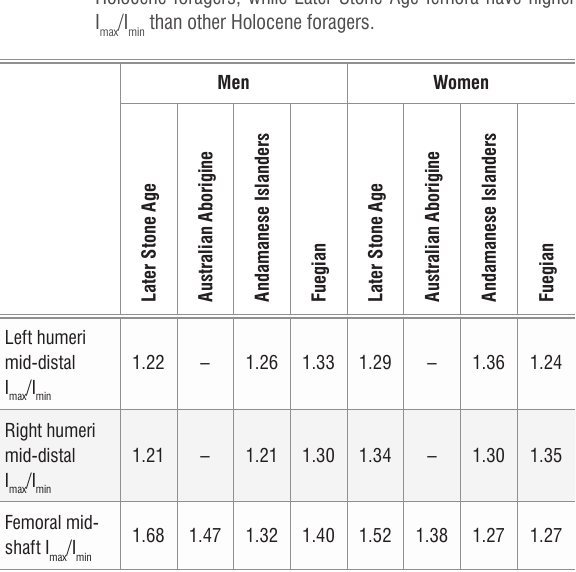
Comparison of Holocene forager humerus and femur I Later Stone Age humeri have similar or lower I Holocene foragers, while Later Stone Age femora have higher I /I than other Holocene max min